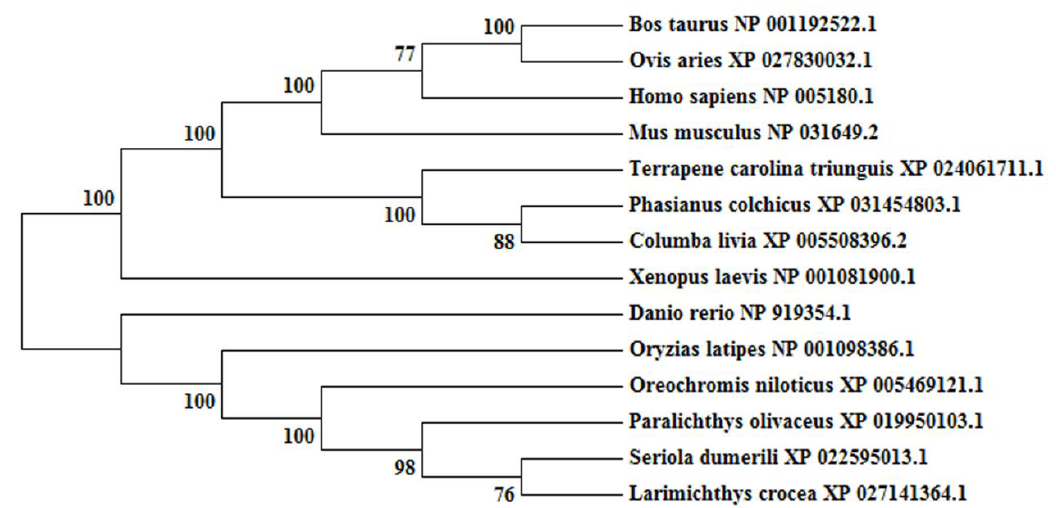
Figure 3. Phylogenetic tree of CBX2 in vertebrates. Bootstrap values are marked at the branch points.